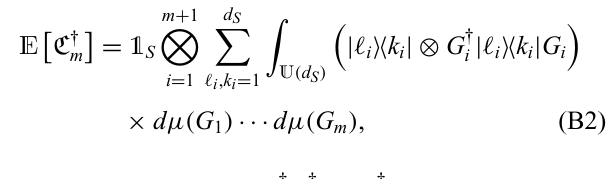
FIG. 10. Process tensor for a Markov process ϒ ( M ) no temporal correlations, can be described by the Choi state ϒ ( M ) taking a product of Choi states (cid:16) j : i connecting adjacent time steps i to j . Each (cid:16) j : i corresponds to a CP map describing the (open) system evolution between time step i and j